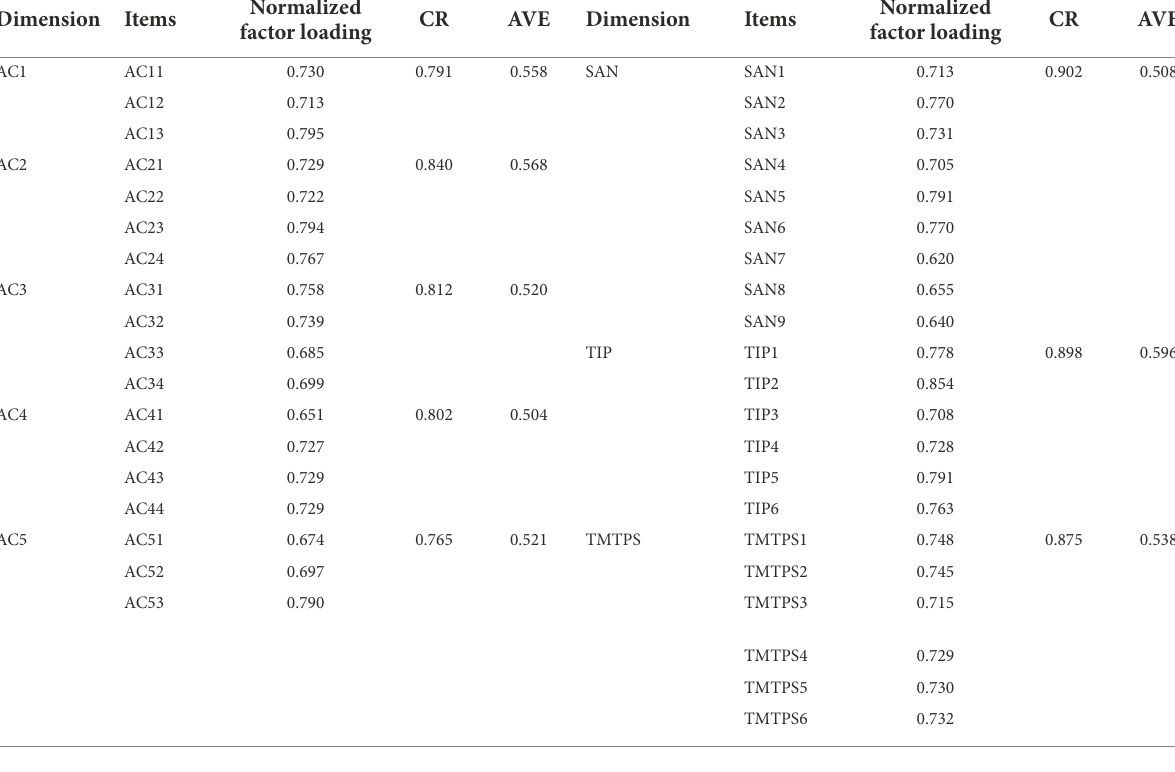
TABLE 3 Results of aggregation validity test.